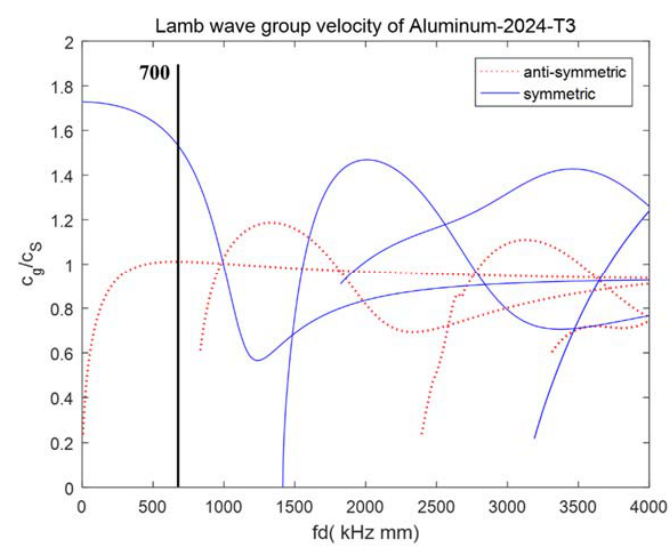
Figure 8. The layout of piezoelectric sensor network.